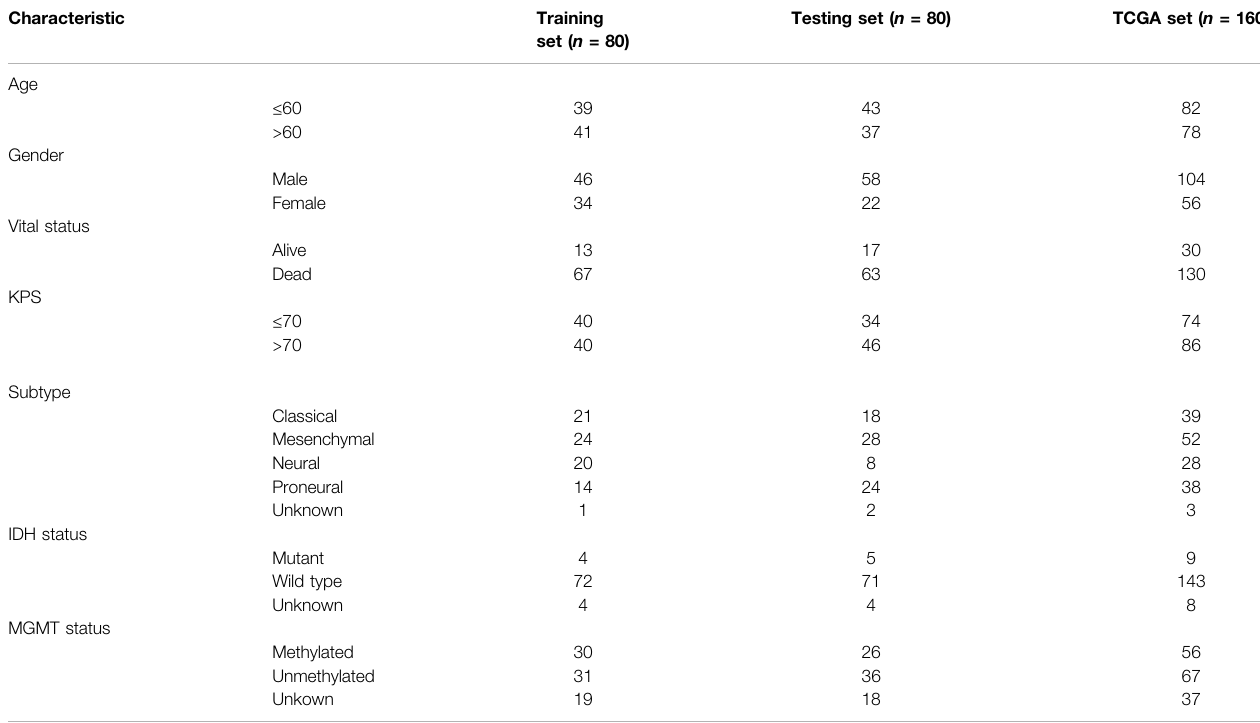
TABLE 2 | Clinical and molecular features of GBM patients.